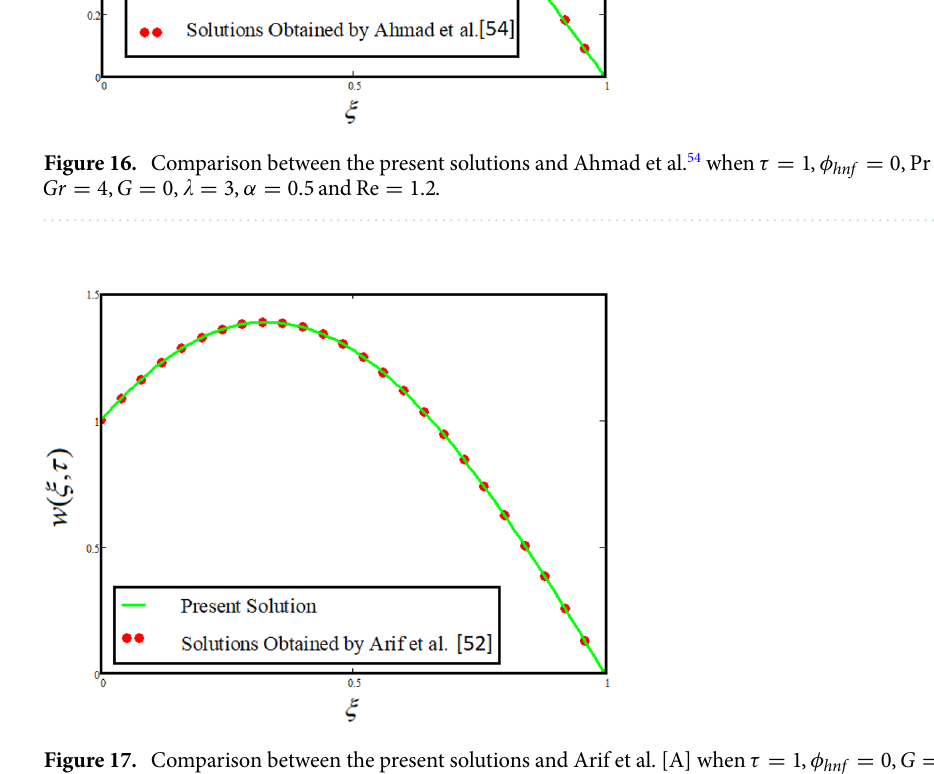
Figure 17. Comparison between the present solutions and Arif et al. [A] when τ = 1 , φ hnf = 0 , G = 1.2 , (cid:31) = 3 , α = 0.5 and Re = 1.2 .